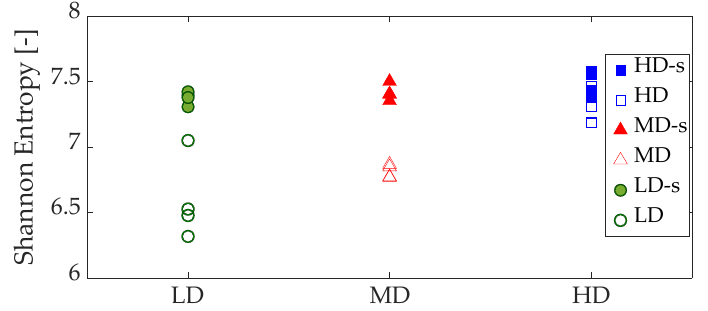
Figure 14. Image Shannon entropy results of each specimen analyzed, speckled (-s) and